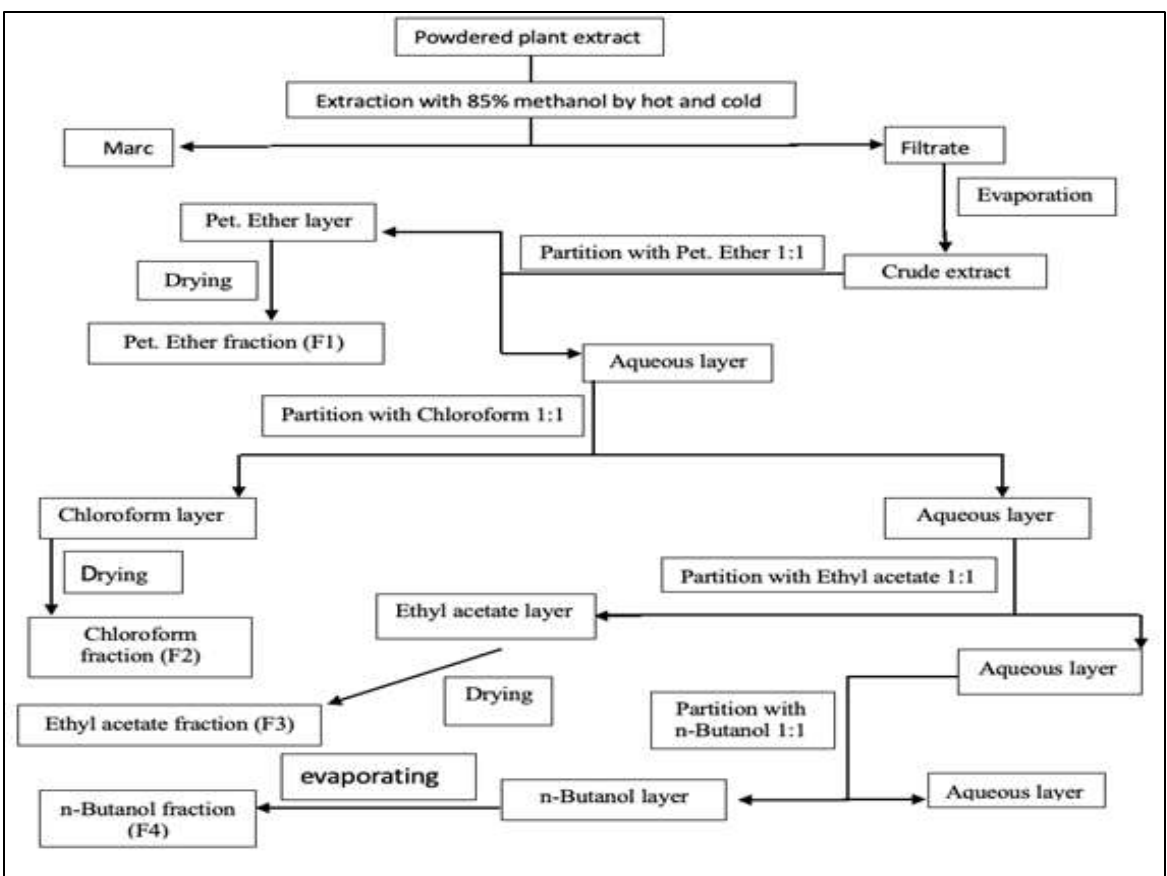
Figure 1. Schematic diagram illustrates the process of extraction and fractionation (12–17)